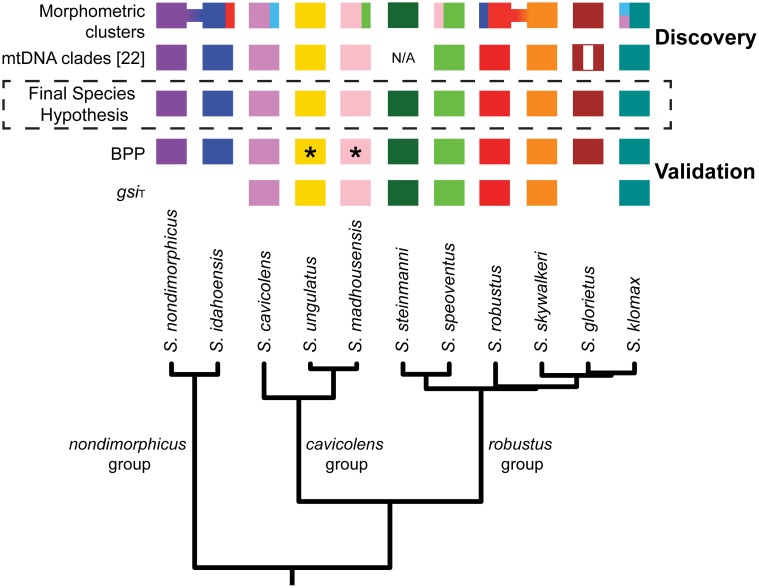
Results of integrative species delimitation.Solid color boxes indicate successful identification or delimitation of a species for the particular approach. For the morphometric clustering method, connected boxes indicate clusters including specimens from multiple species within the same species group. Clusters including specimens from multiple species from different species groups are indicated with multicolor boxes. For the mtDNA analyses [22], the vertically striped box for S. glorietus indicates paraphyly. For S. steinmanni, only one specimen was sequenced, so mitochondrial monophyly could not be assessed. For BPP analyses, asterisks indicate that S. ungulatus and S. madhousensis were not supported in analyses with certain prior combinations (see Results). Only species with gsiT values greater than 0.8 are indicated.